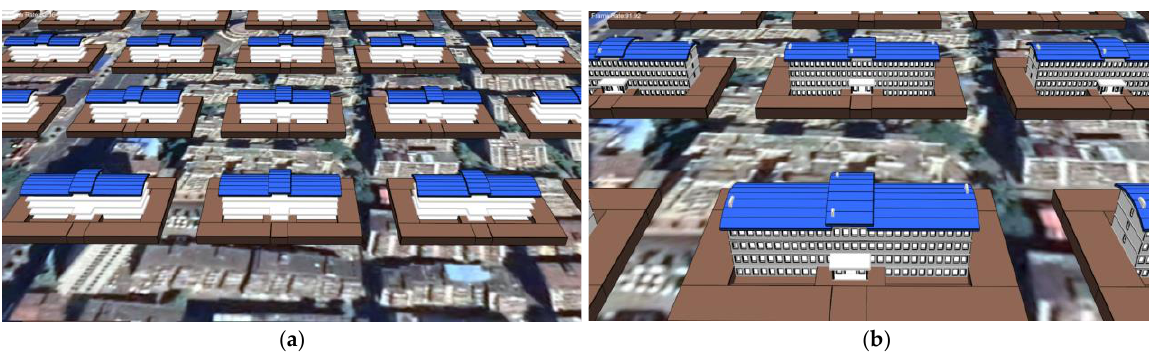
Figure 10. BIM models for the cyan area: ( a ) LOD2 models; ( b ) LOD3 models.